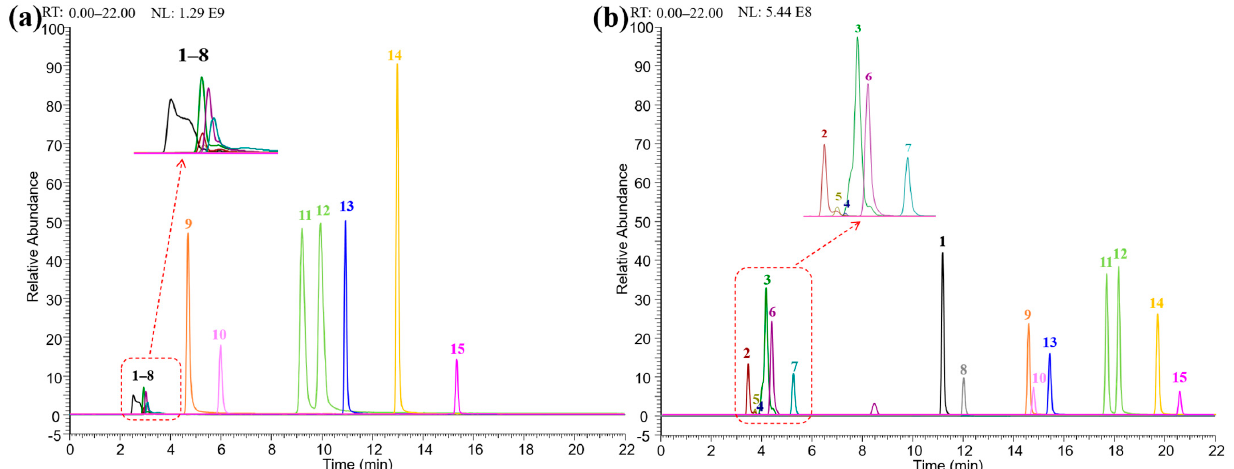
Figure 4. Derivatization of a complex sample. ( a ) EIC-MS profile of AAs in cell culture medium DMEM. ( b ) EIC-MS profile of CAAs in cell culture medium DMEM after derivatization. AAs are